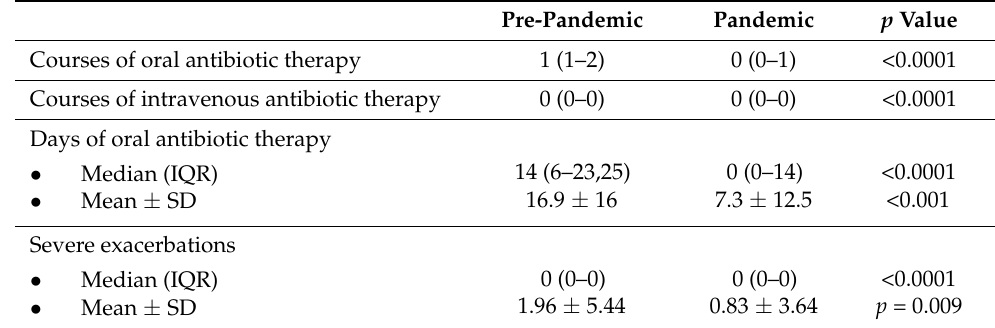
Figure 3. Percentage of patients who experienced 0, 1, 2, 3, or >3 exacerbations in the pre-pandemic and pandemic periods. Table 2. Antibiotic courses and accumulated days of oral and intravenous antibiotic